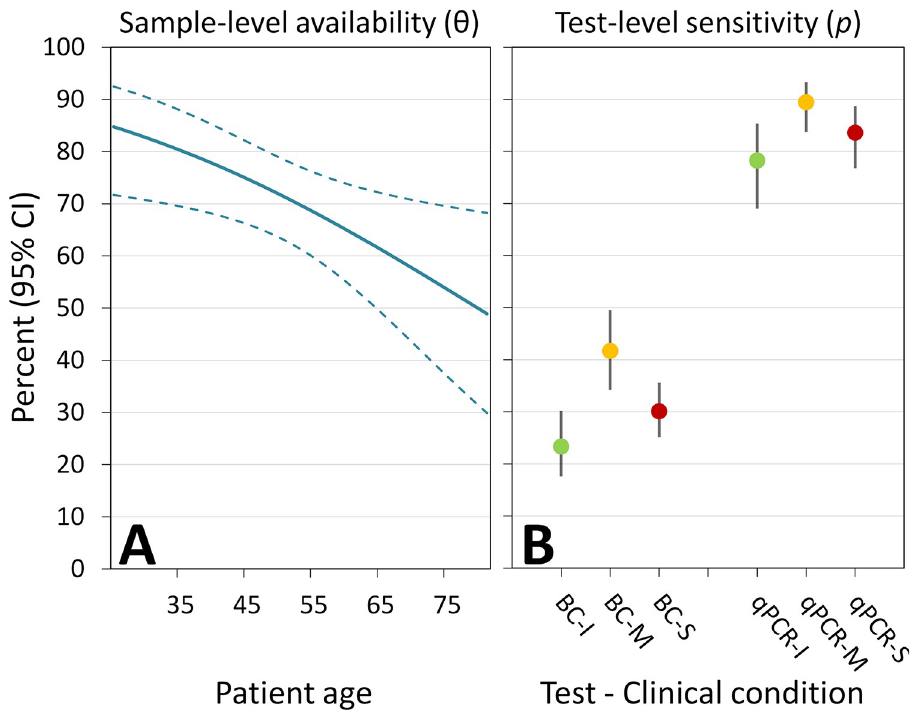
Fig 1. Availability of T . cruzi in blood samples drawn from chronically infected patients ( θ , panel A) and sensitivity of diagnostic tests run on samples in which T . cruzi was available for detection ( p , panel B). The percentages and 95% CIs are predictions from the top-ranking model (“M Top = M 1/age/test+condition ”) in a set of 20 competing hierarchical models (see Table 1). In panel ( A ), patient age is shown in years; in panel ( B ), the results refer to 2 types of tests (blood culture, “BC”; and “qPCR”) and 3 patient conditions: indeterminate (“I”), mild (“M”), and severe (“S”) chronic Chagas disease. Sample-level availability ( θ ) can be seen as a measure of the frequency at which parasitemia “pulses” occur, and differences in test-specific sensitivities ( p ) across clinical conditions as an approximation to the intensity of those pulses of parasitemia—all else being equal, denser bloodstream parasite populations will lead to increased sensitivities (see [7] and S1 Fig). Numerical values used to build these graphs are provided in S1